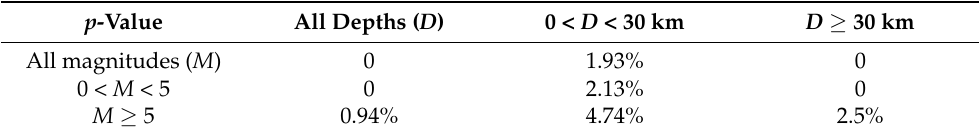
Figure 5. Frequency distributions of the tidal phase angles for the three subsets with a depth ≥ 30 km and different cutoff magnitudes: ( a ) any M; ( b ) 0 < M < 5; ( c ) M ≥ 5. Table 2. Statistical significance of the earthquake distributions from the Schuster test.